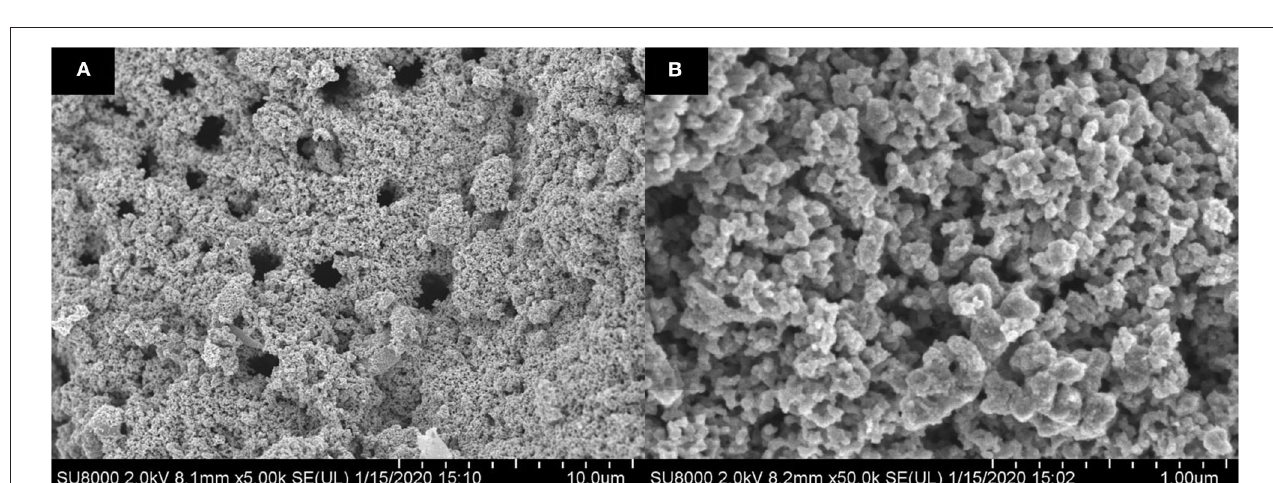
FIGURE 6 | FESEM images of synthesized green TiO 2 NPs with magnifications of (A) 5,000 times and (B) 50,000 times.